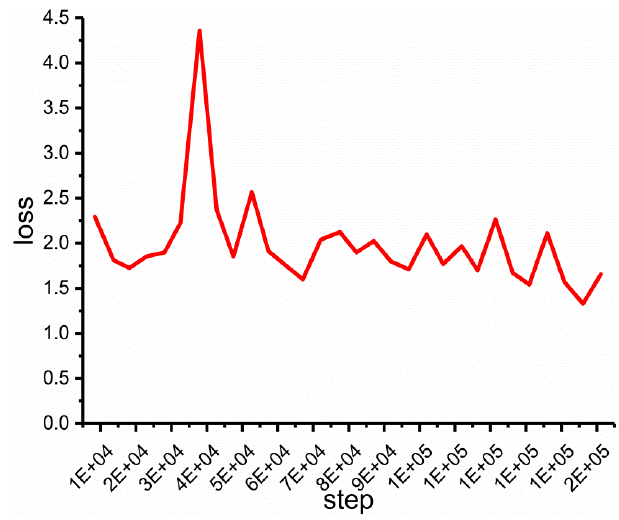
Figure 7. Curve of loss value varying with iterations.